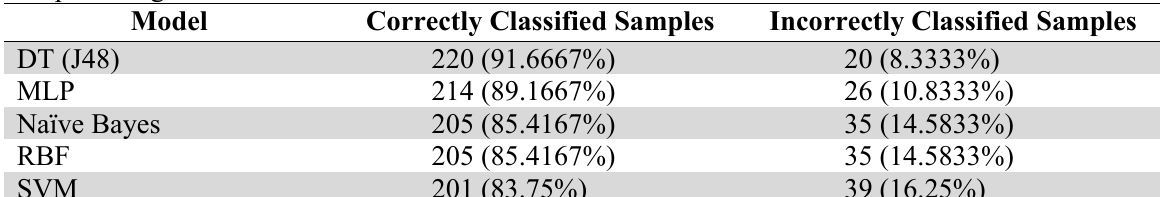
The percentage of accurate and inaccurate classification